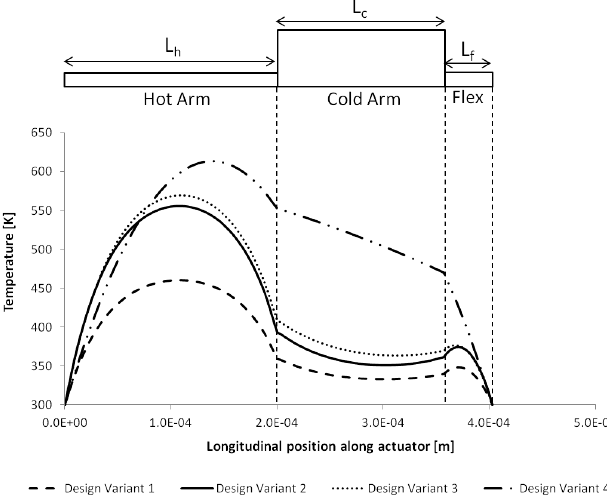
Figure 7. Comparison of the analytical results for the temperature profile along the hot arm, cold arm and flexure components of Design Variants 1-3 at 3 V, and of Design Variant 4 at 14 V. The diagram above the graph illustrates an unfolded thermal actuator without the extending microgripper arms.